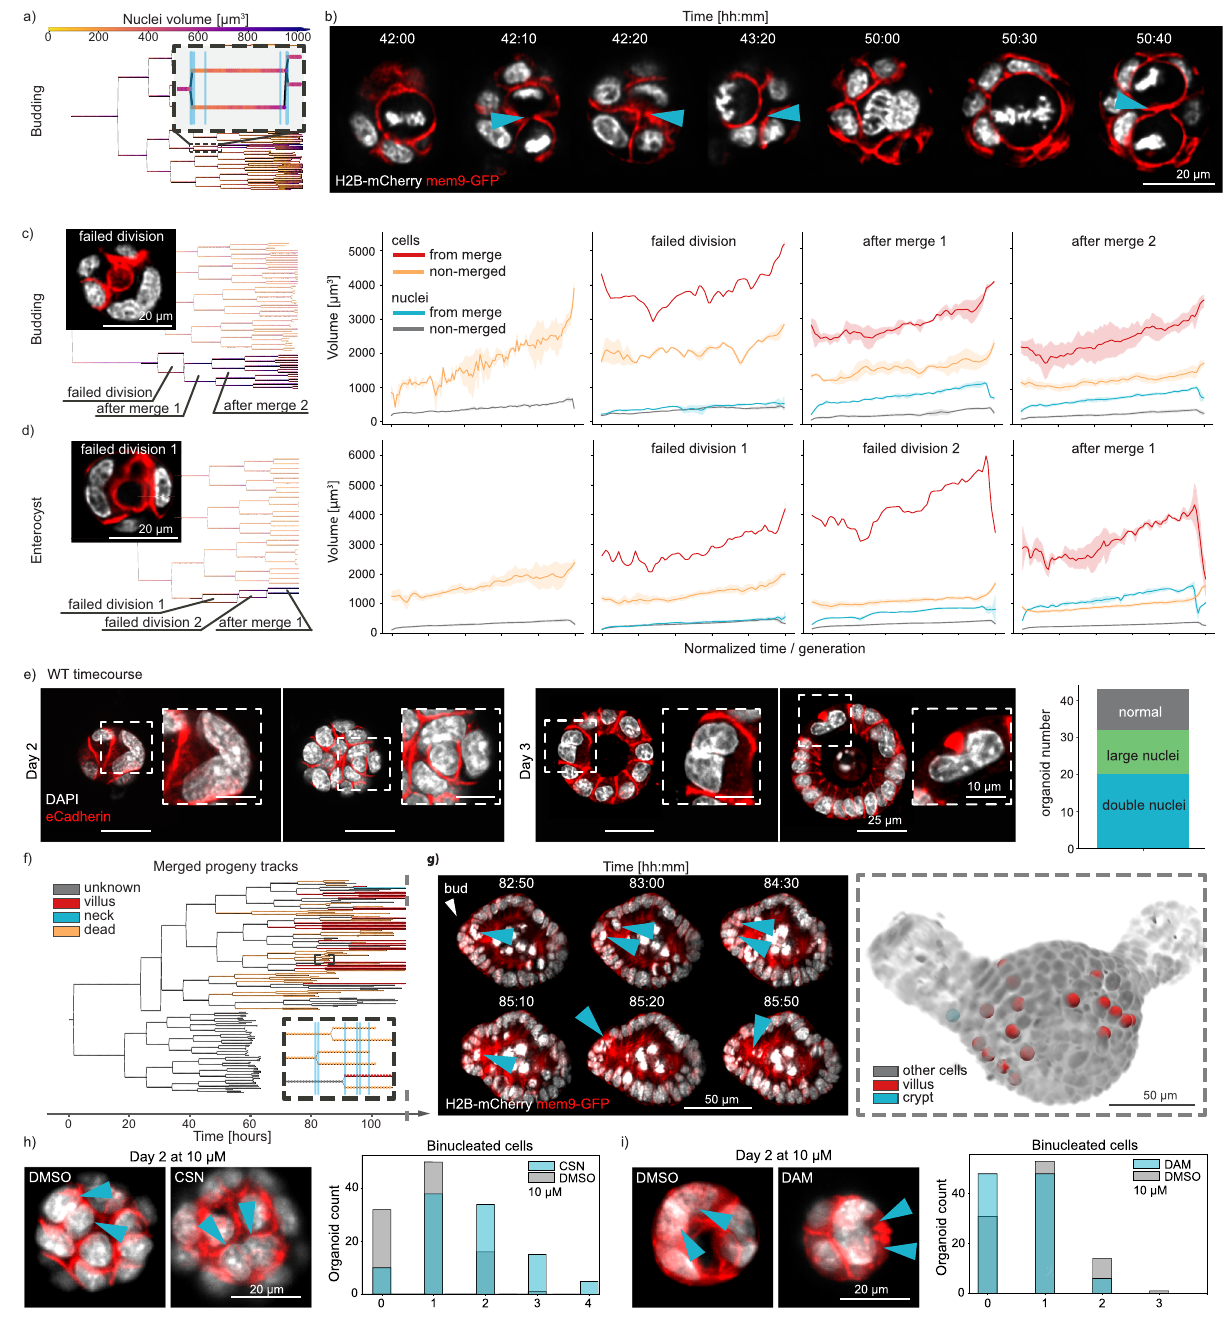
Fig. 5 | Merging events during early organoid growth. a Example lineage tree with highlighted insert depicting a cell division where two nuclei divide again into twonuclei(recording002). b Stillimagesofthelight-sheetrecordingrelatedtothe dataset in ( a ). Cyan arrows mark the position of a connecting region between the two nuclei until the following division occurs, where cytokinesis is successful. Correspondinglocationsforeachdepictedtimepointonthelineagetreeareshown as cyan lines in the insert in ( a ). c , d Examples of different sequence of events followingafaileddivisionduringbuddingorganoid(recording001)andenterocyst (recording 003) growth (left),with quanti fi ed nuclei and cell volumes for the highlighted events on the trees (right). Whenever more than one track is being evaluated for the same label, the full line represents the mean whereas the shaded region corresponds to 95% of the con fi dence interval. e Timecourse data on wild- type intestinal organoids grown from single cells and fi xed at days 2 and 3 after seeding. Staining with DAPI and e-Cadherin show bi-nucleated cells and cells with large nuclei. Major axis length of all nuclei after a failed division (green) and all